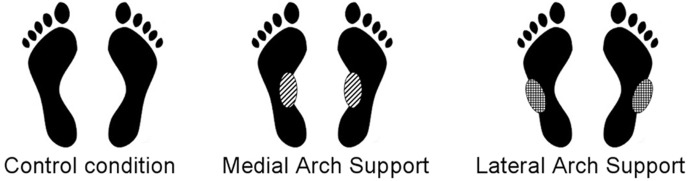
Posturography testing conditions.3 mm thick inserts (SH 60A, 250 kg/mm²) were placed in the midfoot region: on the medial half of the external band of the footprint (MAS condition), or on the lateral half (LAS condition).